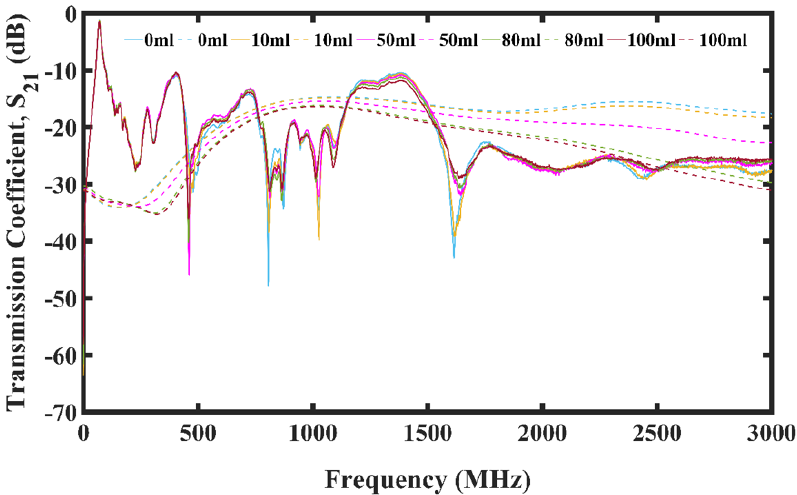
Figure 7. Plot showing transmission coefficient for oil spill using 15 mm antenna-sensors spacing.